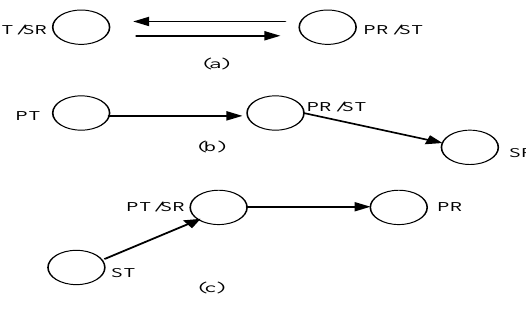
Figure 6. Full duplex (FD) Opportunity